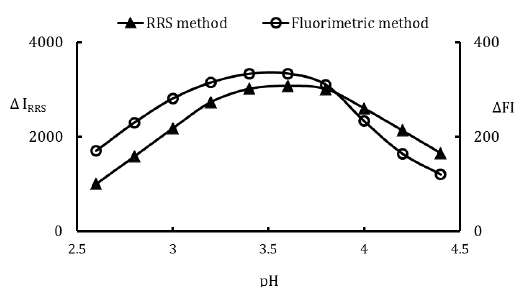
Figure 5: Effect of pH on the fluorescence quenching effect and RRS enhancement of the association complex formation between cyclobenzaprine (1.0 μg/mL) and eosin Y.